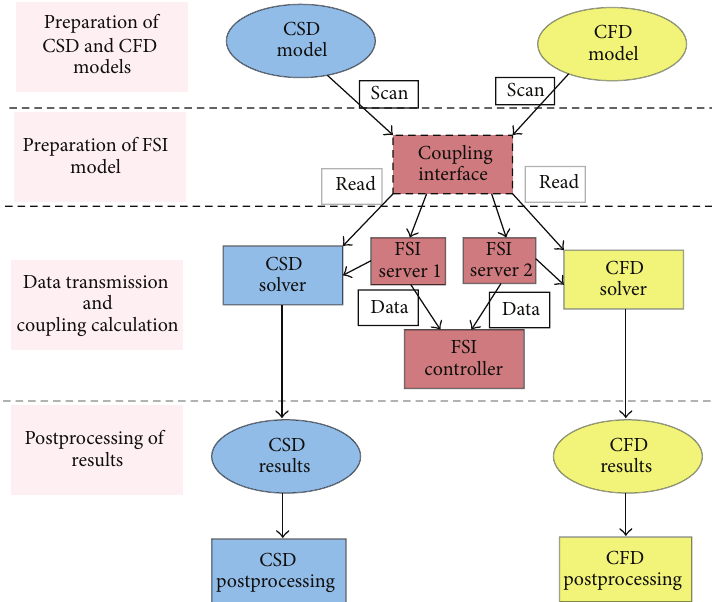
Figure 4: The process of FSI